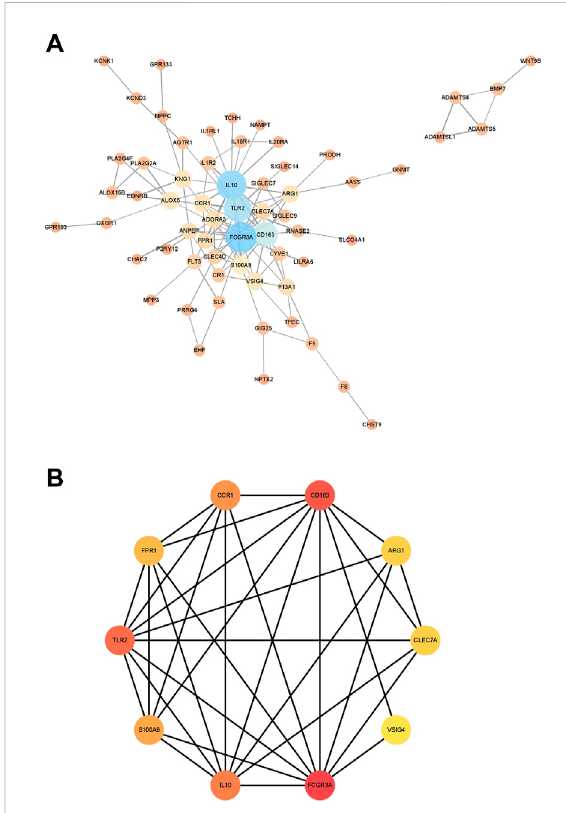
FIGURE 6 The results of PPI network. (A) . The PPI network were analyzed using NetworkAnalyzer plugin. (B) . The hub genes with the top 10 scores. The size and color of the nodes represent the importance of genes in the interaction network. The larger the node or the darker the color, the more important the corresponding gene is in the network. The connection between the nodes represents the interaction between the two genes, and the wider the connection line, the stronger the interaction between the two genes.